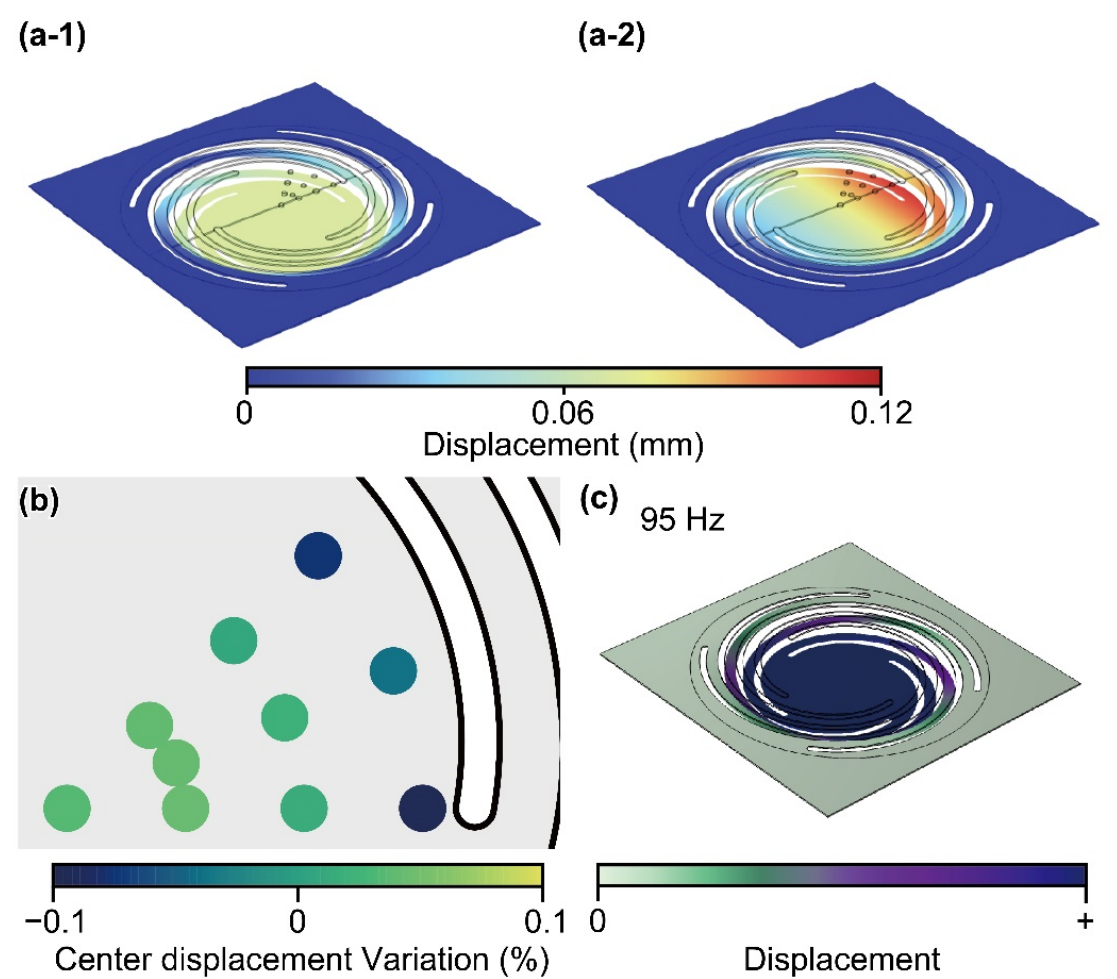
Figure 4. ( a ) Simulation results of the deformation when a force is applied to ( a-1 ) the center point and ( a-2 ) the outermost point. ( b ) Spring constant variation determined from simulations. ( c ) Simulation result of the first resonant frequency.